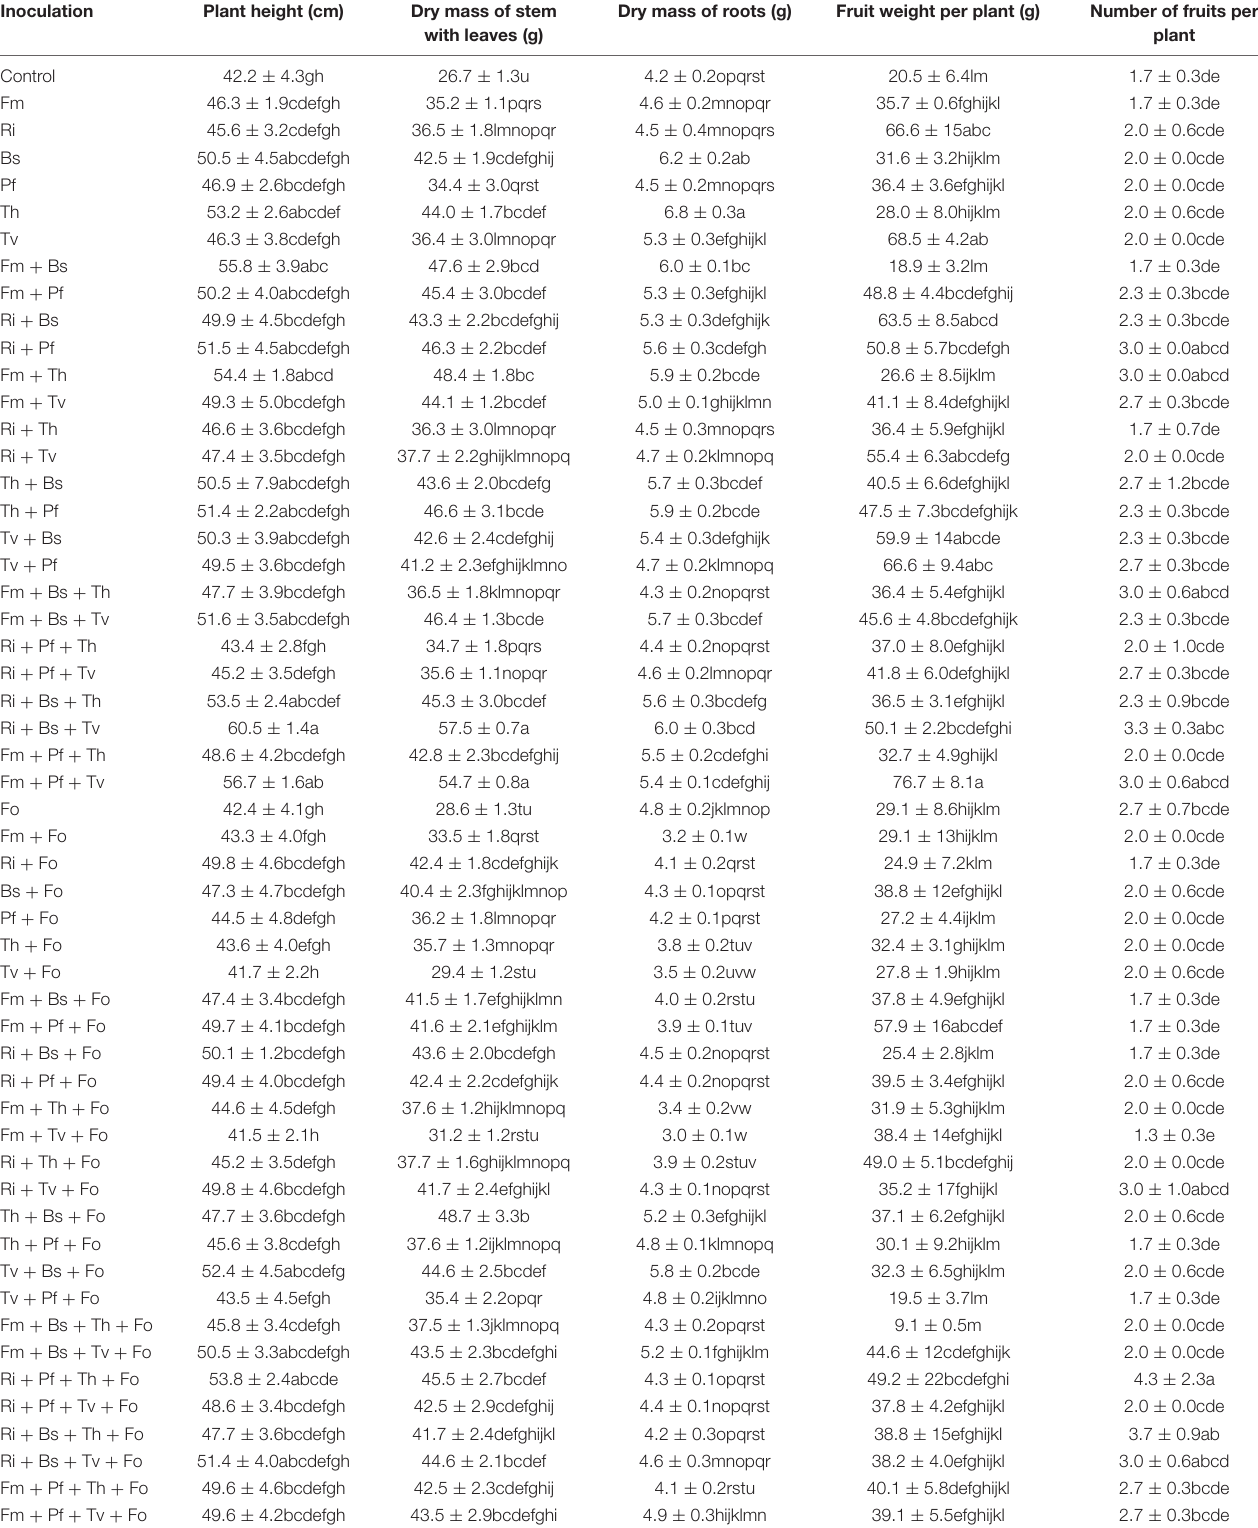
TABLE 2 | Influences of AMF, PGPR, Trichoderma spp., and Fusarium oxysporum f. sp. radicis-lycopersici on tomato growth and yield. Inoculation Plant height (cm) Dry mass of stem Dry mass of roots (g) Fruit weight per plant (g) Number of fruits per with leaves (g)